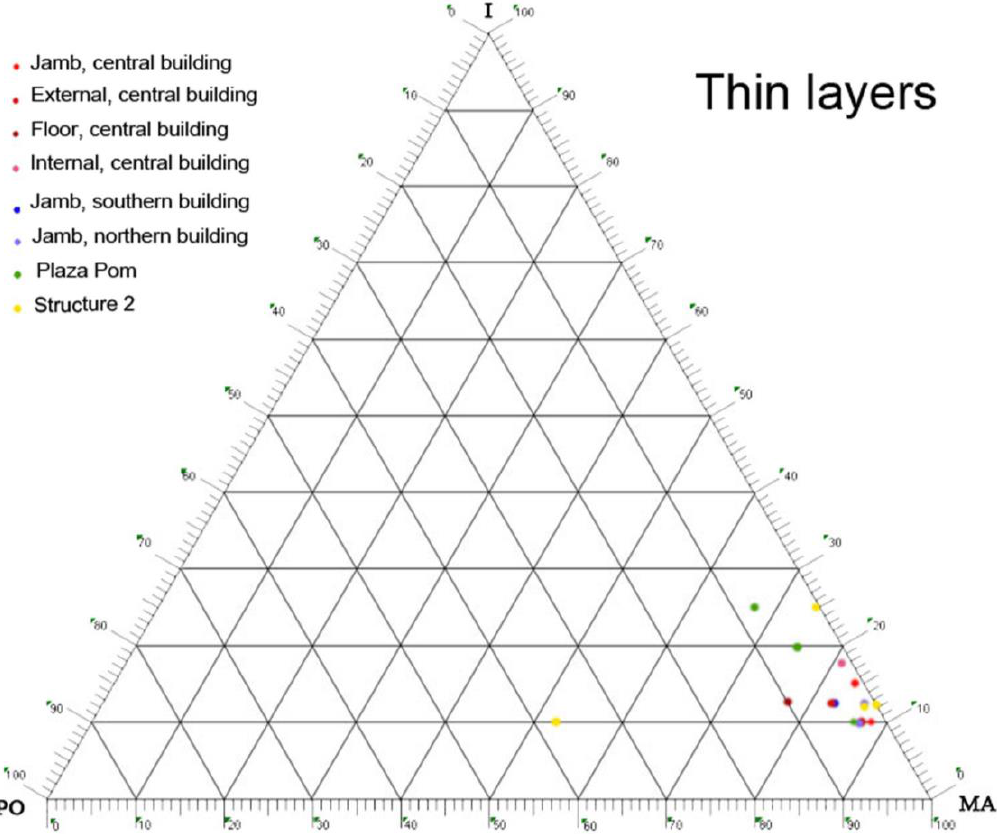
Figure 8. Ternary plot showing the proportions of inclusions, matrix, and porosity of the thin layers within the plasters.